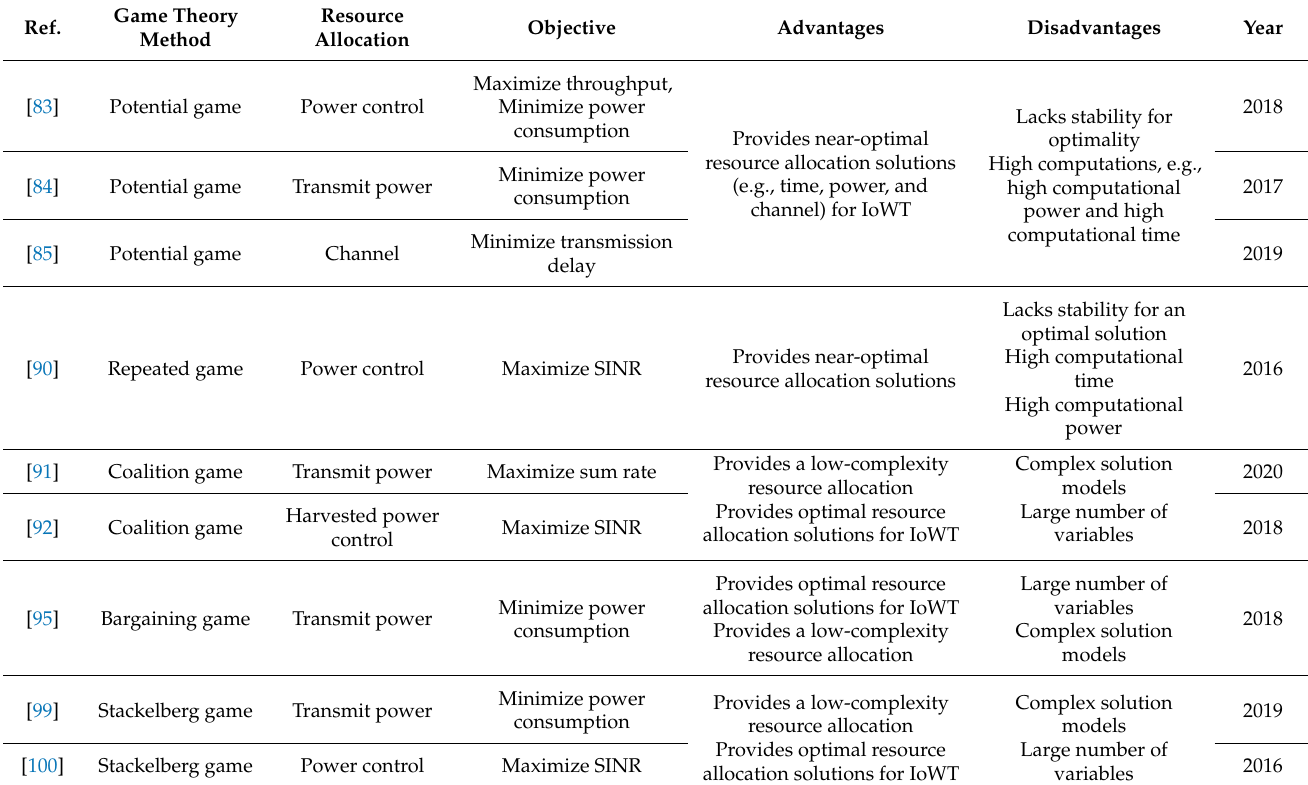
Table 2. Summary of resource management solutions based on game